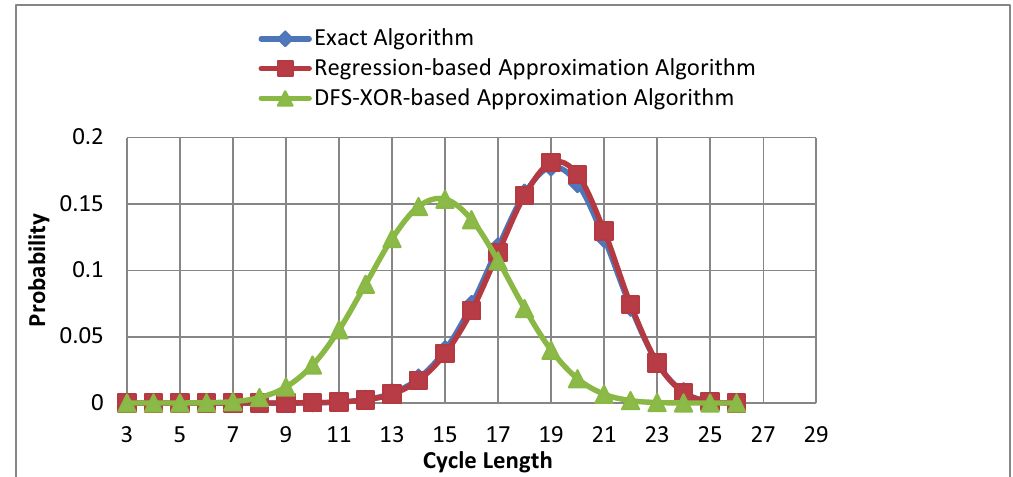
Figure 3. Comparison of the probability distribution of the three different